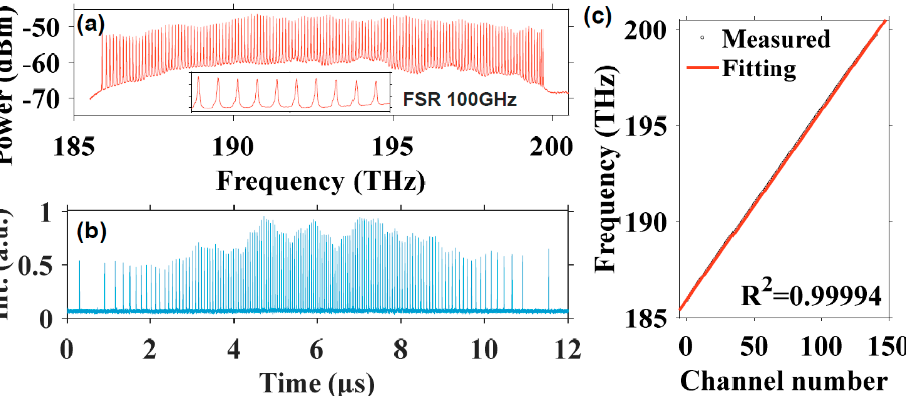
Figure 13. The ( a ) spectrum (the inset is a zoom-in view from 193 to 194 THz) and ( b ) temporal waveform of the discrete FDML laser with 100 GHz FSR. ( c ) The central frequency of the comb lines versus the channel number with a linear fitting. Reprinted with permission from Ref. [87].